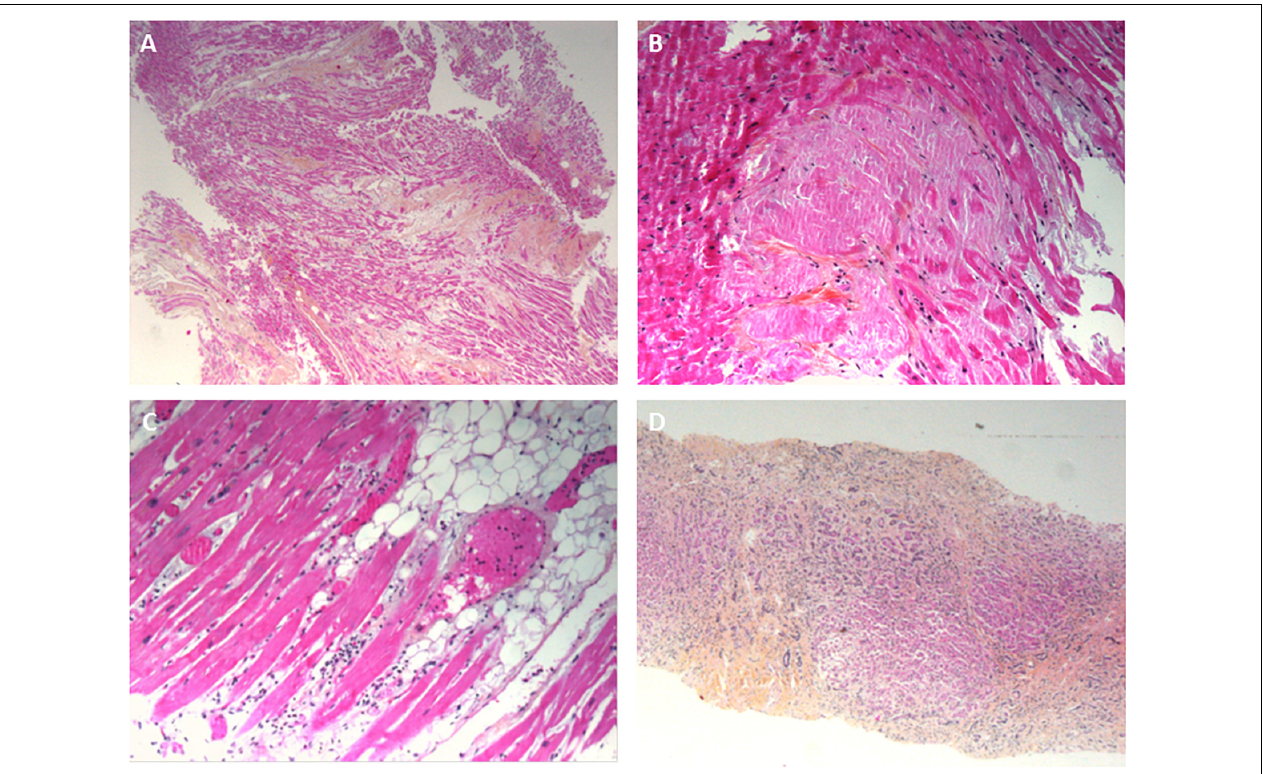
FIGURE 4 | Pathology findings for other organs in deceased patients with COVID-19. (A) Ischemic cardiomyopathy, with a fibrous scar in the myocardium; hematoxylin-eosin-saffron, × 100. (B) Cardiac amyloidosis, with eosinophilic deposits of amyloidosis around the myocytes; hematoxylin-eosin-saffron, × 400. (C) A myocardial biopsy showing a mild inflammatory infiltrate around the myocytes. (D) Liver cirrhosis: extensive fibrosis surrounding micronodules composed of small hepatocytes. Numerous cholangioles and mononuclear inflammatory infiltrates in the fibrous bands; hematoxylin-eosin-saffron, × 100.